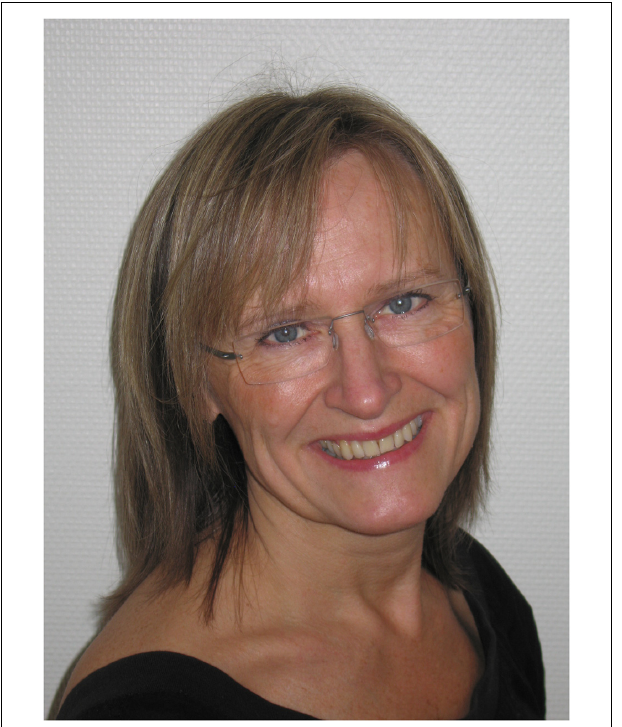
FIGURE 4 | Hilda Molina, reproduced from Hariz et al. (2014).